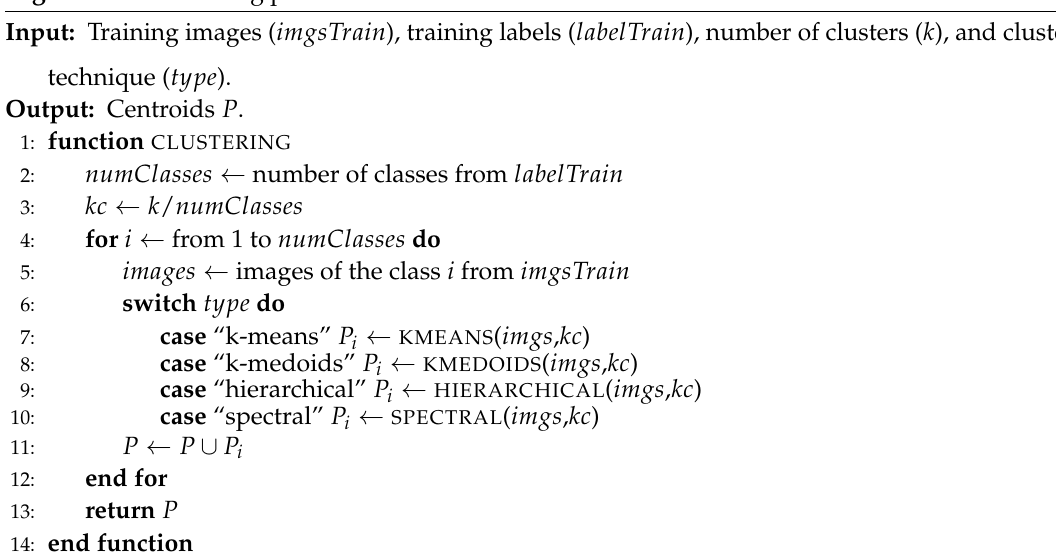
Algorithm 4 Clustering